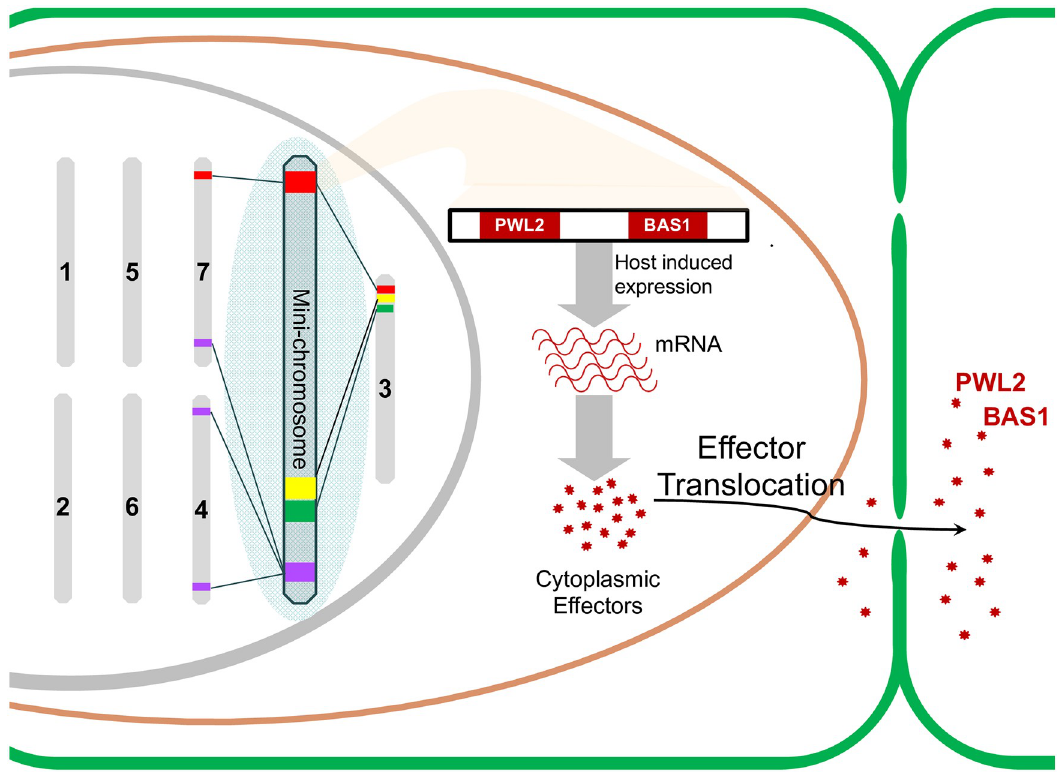
Fig 1. Cartoon illustration of the mini-chromosome, highlighted in light blue background, in the reference genome of Magnaporthe oryzae Triticum pathotype (MoT) [3]. While seven core chromosomes, demonstrated as gray bars, are conserved in the rice blast fungus M . oryzae Oryzae pathotype (MoO), this mini-chromosome is absent. It contains large duplications from ends of core chromosomes and is enriched for effector genes and other genes involved in host invasion. Also illustrated here are two cytoplasmic effectors, PWL2 and BAS1 . They are physically linked in the mini-chromosomes, and their expression are induced specifically during wheat infection. As documented in MoO, cytoplasmic effectors effectors can translocate into plant cells via the biotrophic interfacial complex (BIC) and spread to neighboring cells ahead of invasive hyphae [6].